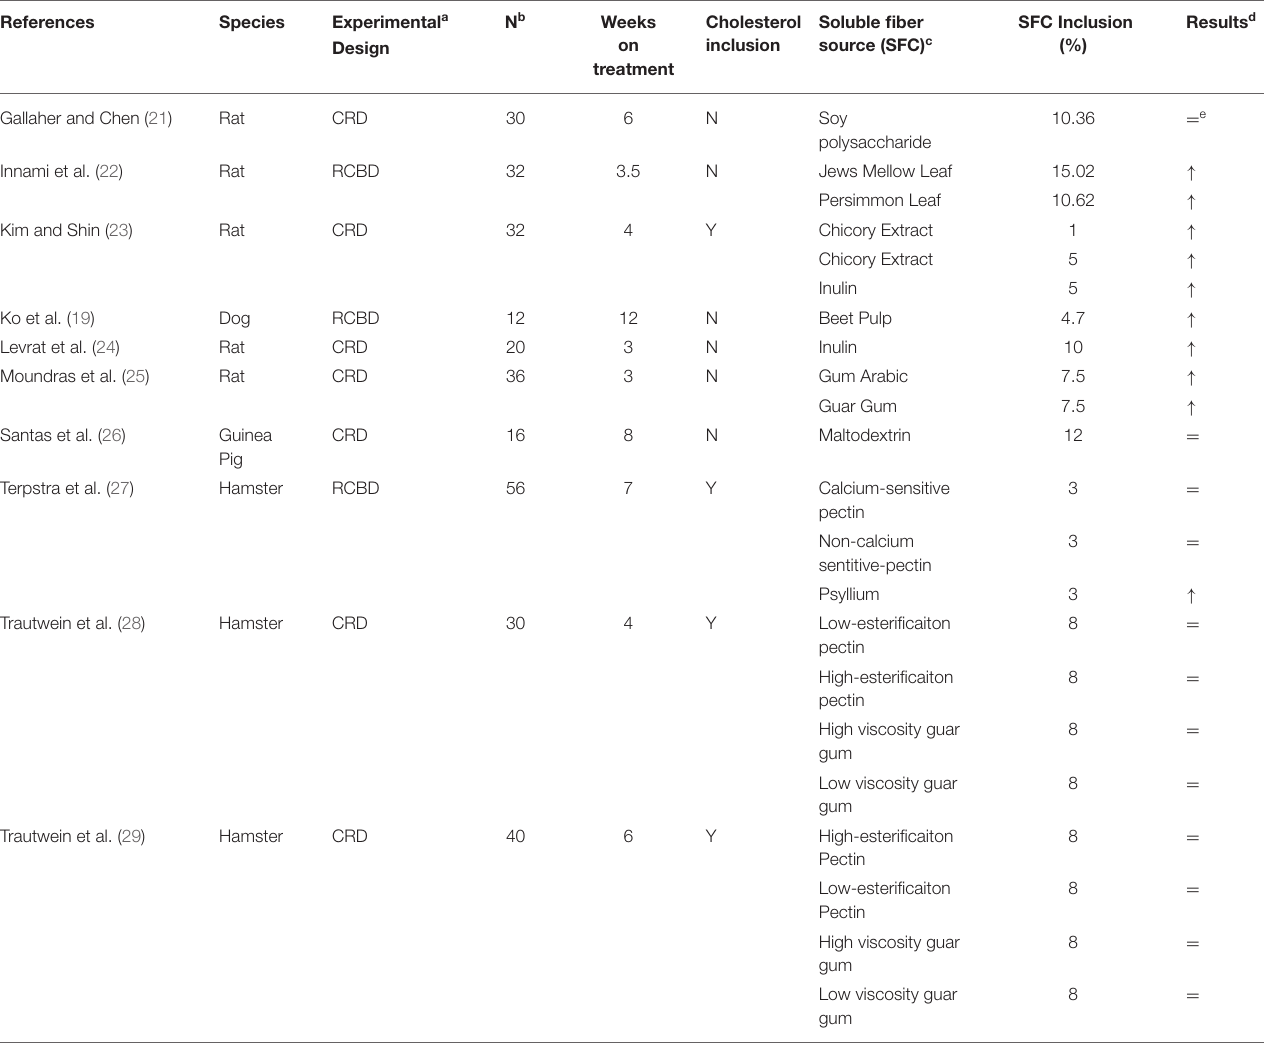
TABLE 1 | Summary description of publications included in the